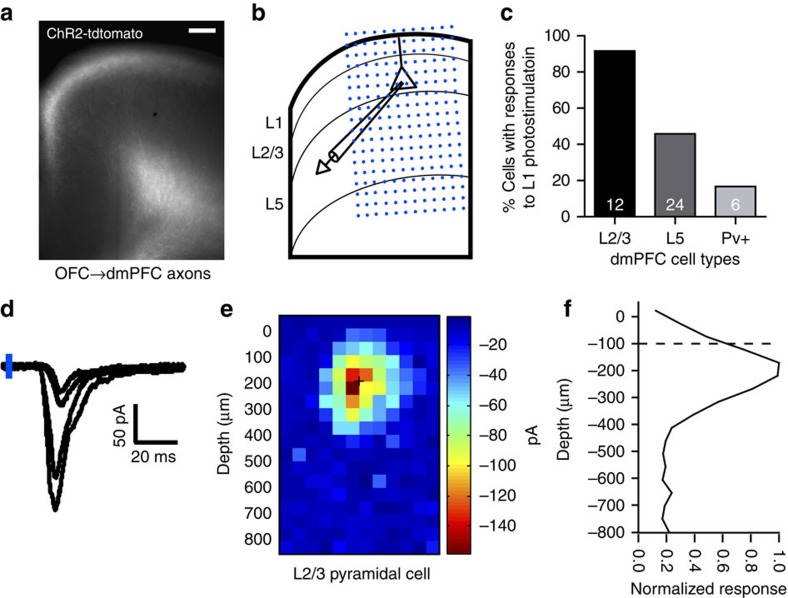
OFC axons make functional synapses onto multiple cell types in the dmPFC.(a) Image showing that OFC axons expressing ChR2-tdTomato project to the contralateral dmPFC. Scale bar, 100 μm. (b) We used photostimulation of OFC axon terminals and whole-cell recording in dmPFC to confirm functional connectivity. A 12 × 18 photostimulation grid (50-μm spacing) was used to assess laminar input patterns. (c) Proportion of cell types in dmPFC with current responses to photostimulation of L1 OFC axons. Cell types include L2/3 and L5 pyramidal cells identified by morphology and distance from the surface, and parvalbumin-positive (Pv+) putative interneurons identified in Pvalb-IRES-Cre mice. Number insets are the number of cells recorded. (d) Example current traces from axon terminal photostimulation pulses at different locations in the grid. (e) Heat map of current responses in a L2/3 pyramidal cell to photostimulation of OFC axons from the contralateral hemisphere. Note that the first row is outside of the slice. + Indicates location of the soma. (f) Quantification of the responses in e by depth from the surface. Responses were normalized to the maximum response. OFC axons in L1 (indicated by dashed line) are capable of driving substantial responses in the soma.